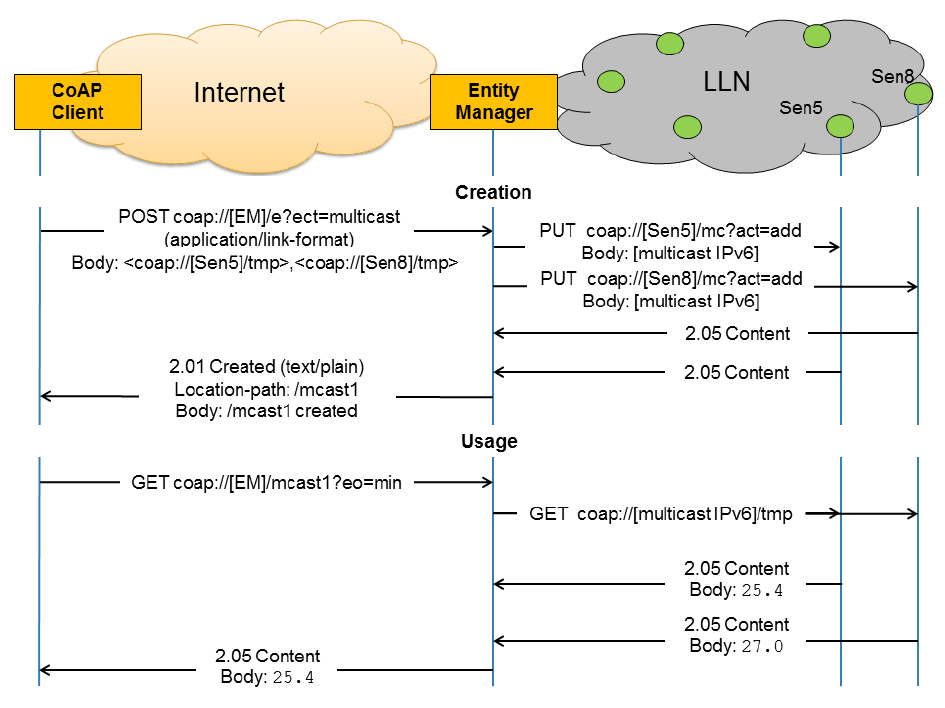
Figure 4. An example of the creation and usage of a multicast entity. LLN, Low-power and Lossy